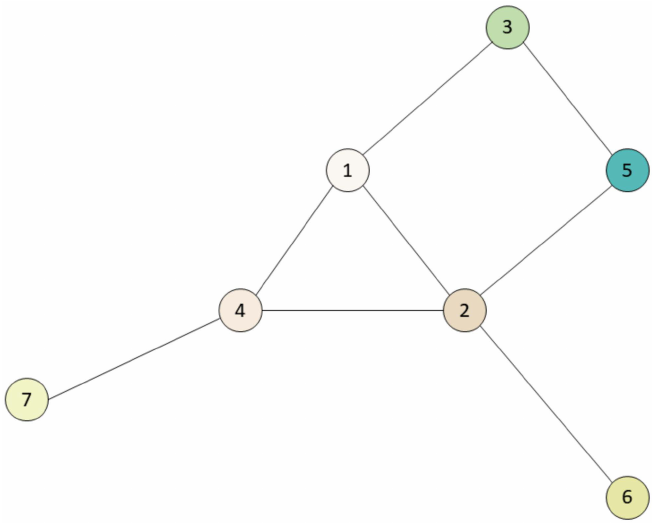
Figure 1. Example network of the edge importance greedy